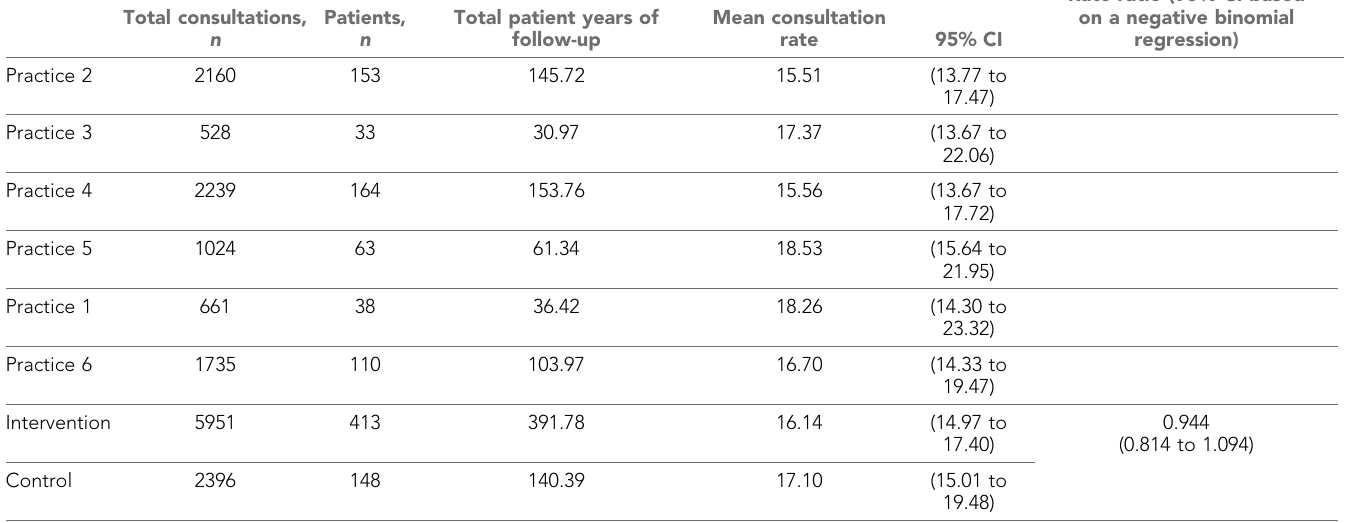
Table 2 Comparison of consultation rates at 12-months post-randomisation Total consultations,